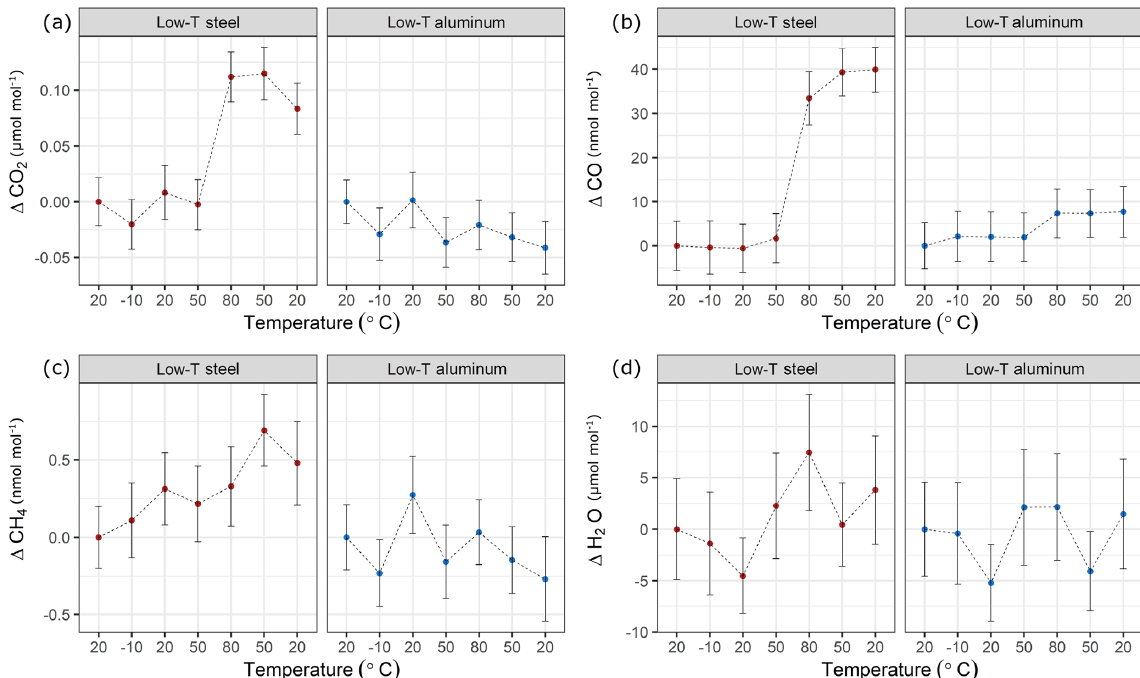
Figure 8. Temperature experiments until 80 ◦ C using steel (red) and aluminum (blue) cylinder for species (a) CO 2 , (b) CO, (c) CH 4 and (d) H 2 O. The x axis corresponds to a temperature cycle, whereas the y axis shows the amount fraction differences relative to the measure- ments at 20 ◦ C. Error bars indicate the standard deviation of the measurements included in the mean.